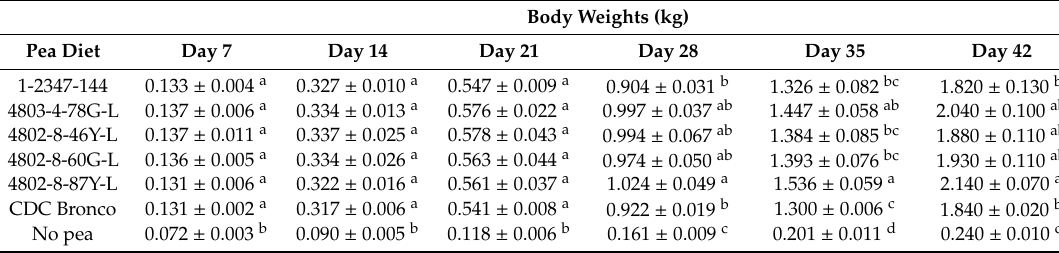
Table 6. Experimental body weights 1 .